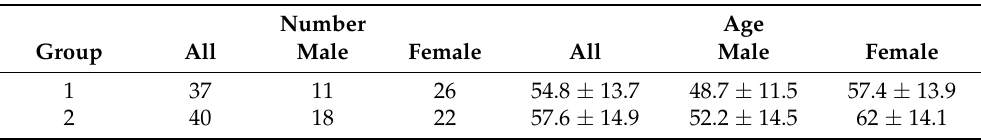
Table 5. The results of the clustering of subjects from group 1. The number and the average age of each group. This table shows no significant differences between these